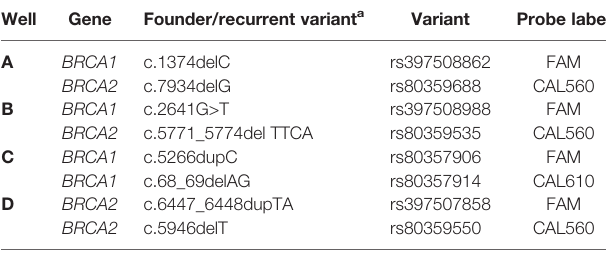
TABLE 1 | Multiplex analysis of eight BRCA1/2 founder/recurrent variants in a four-tube ParaDNA closed system format.